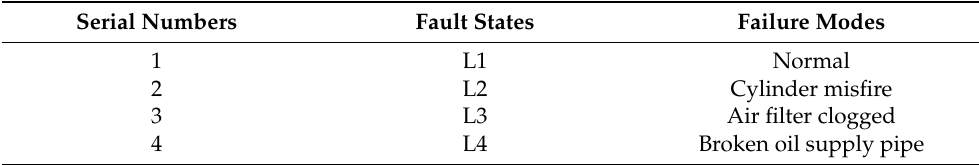
Table 1. The pre-set failure modes of the diesel engine.